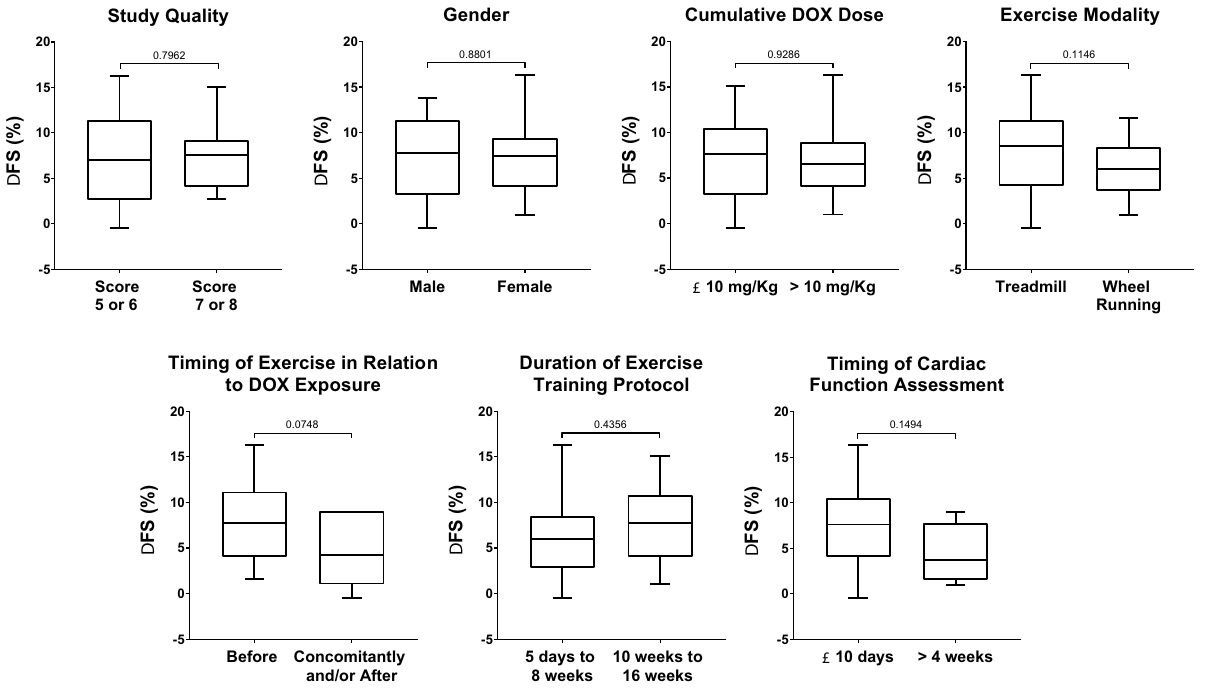
Figure 5. Sensitivity analysis of changes in fractional shortening (FS) based on clinical predictors of exercise training success. Unpaired Student’s T test, p < 0.05.